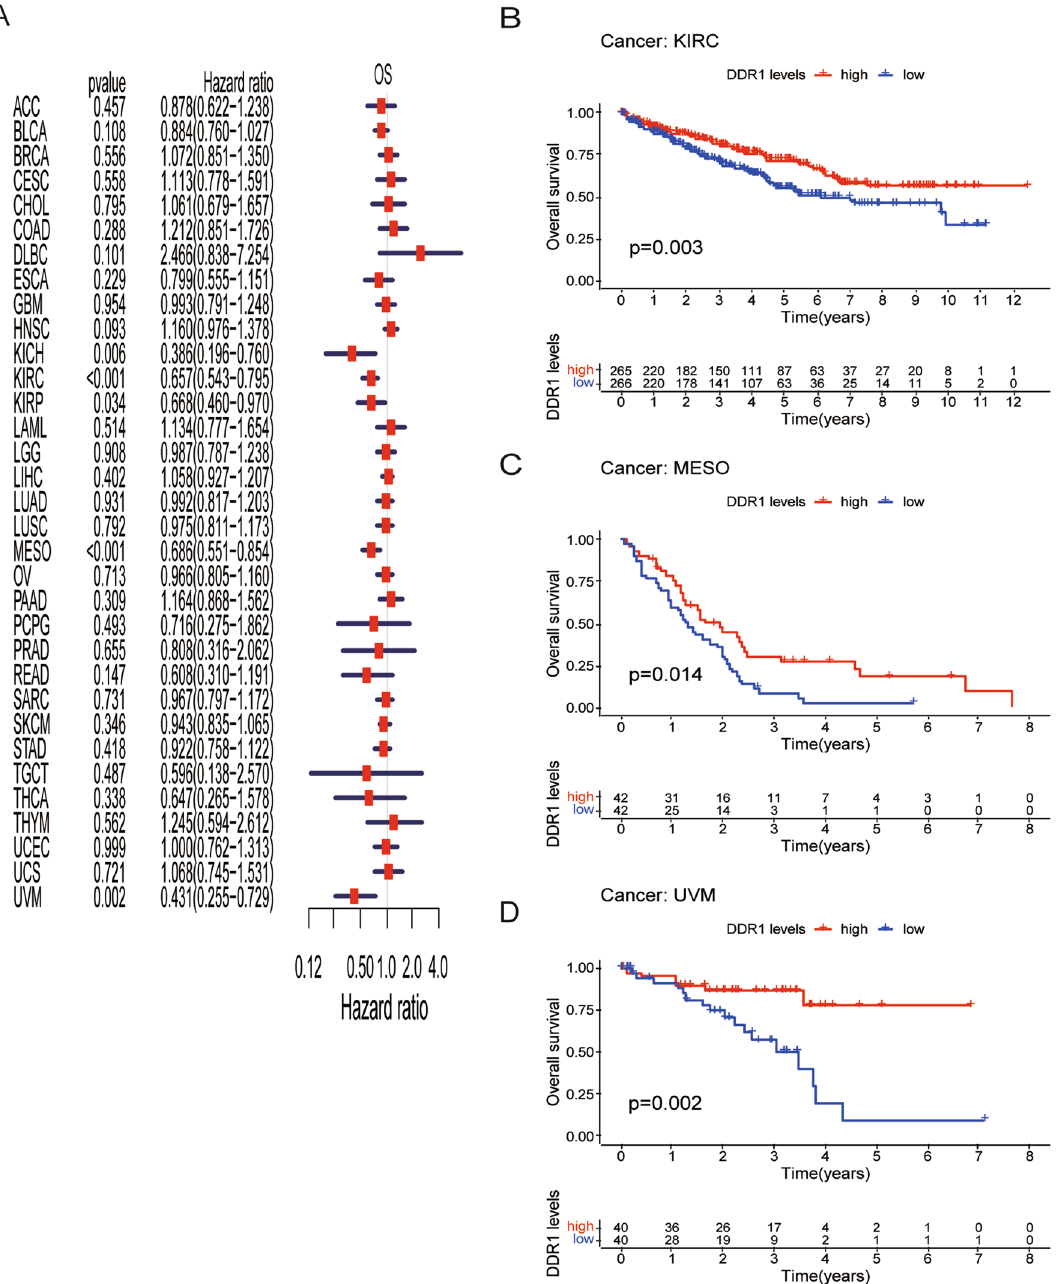
Figure 3. Association between DDR1 expression and overall survival (OS). ( A ) Forest plot shows the univariate Cox regression results for the association between DDR1 expression and OS in 33 types of tumors. ( B–D ) Kaplan–Meier analysis of the association between DDR1 expression and